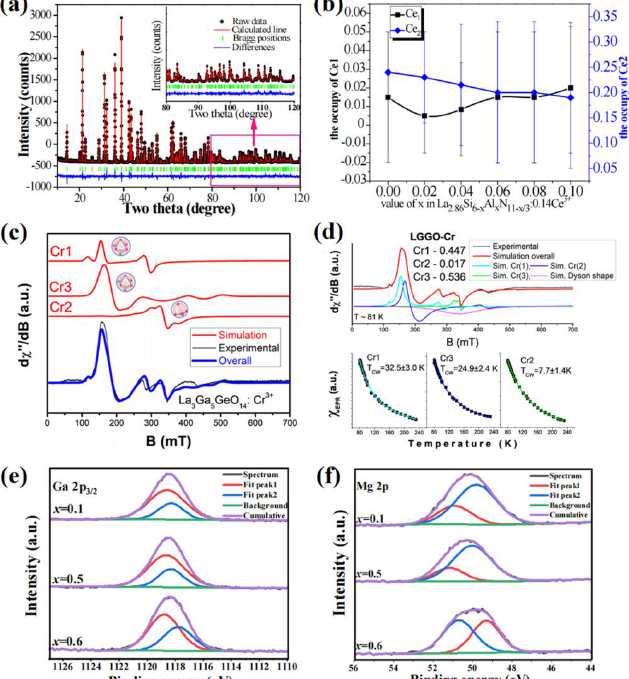
Figure 11. ( a ) Rietveld refinement of the powder data of La 2.86 Si 5.9 Al 0.1 N 10.97 :0.14Ce 3+ . ( b ) Ce occu- pancy of La 2.86 Si 6 − x Al x N 11 − x/3 :0.14Ce 3+ samples from the refinements. Reprinted with permission from